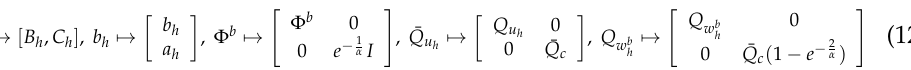
Figure 2. Time–series of the ionospheric estimation–error b h (grey lines). Given 1000 normally distributed samples, the misspecified user-filter computes filtered ionospheric solutions under two cases. ( Left ): Case 1 (10) in which the corrections are considered non-random. ( Right ): State-augmentation (12) in which the time-correlation of the corrections is modelled by an exponential auto-correlation function. The incorrect 99.9% confidence intervals (dashed lines), reported by the user-filter, are compared with their correct versions (black solid